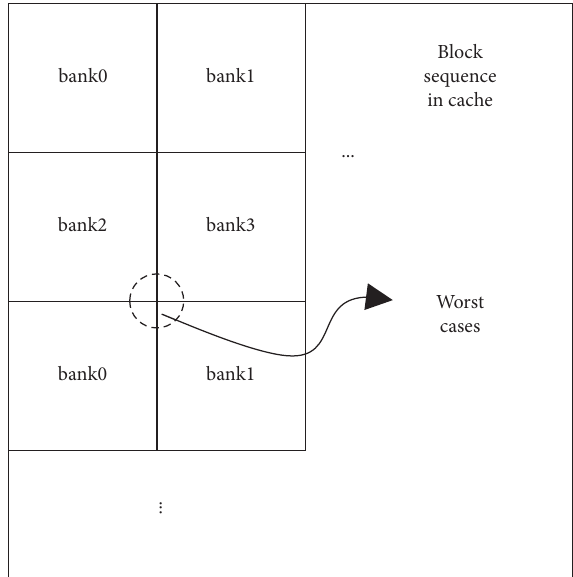
Figure 5: An example of cache mapping strategy. The worst case is when a missing node falls on the corner of the bank and its neighbors fall on 4 banks.